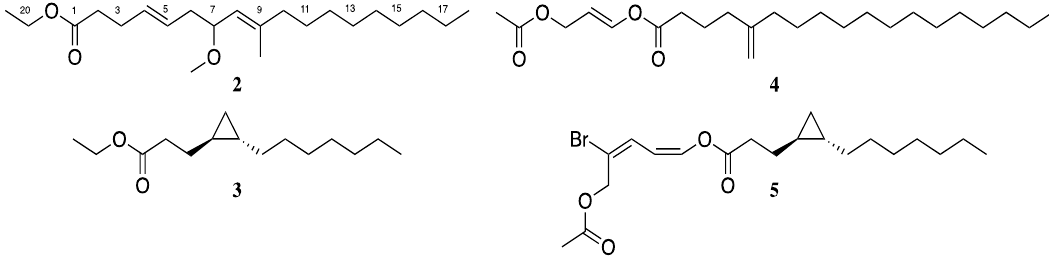
Figure 12. Structures of compounds 2 – 5 from 5-HT 2C active fraction.